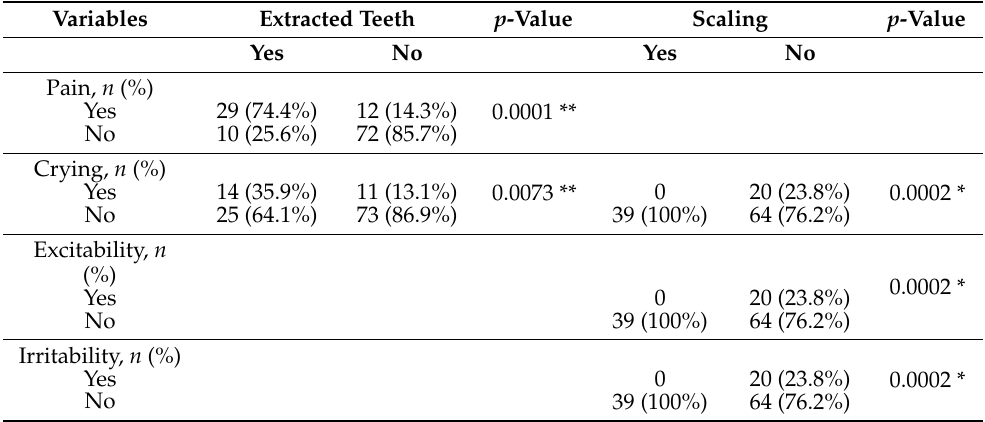
Table 4. Statistical analysis of the post-discharge side effects in relation to dental procedures performed.